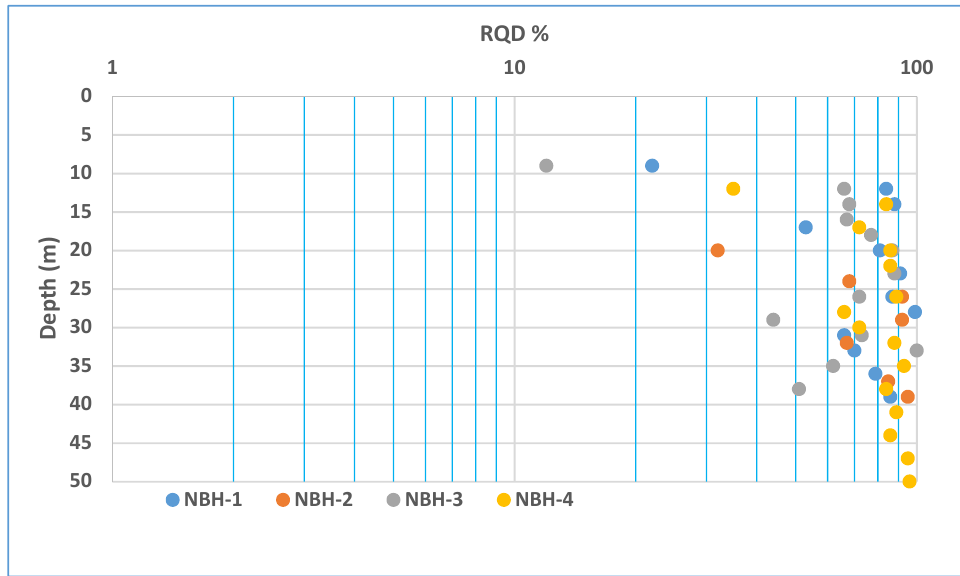
Figure 17. RQD values recorded in NBH-series boreholes.